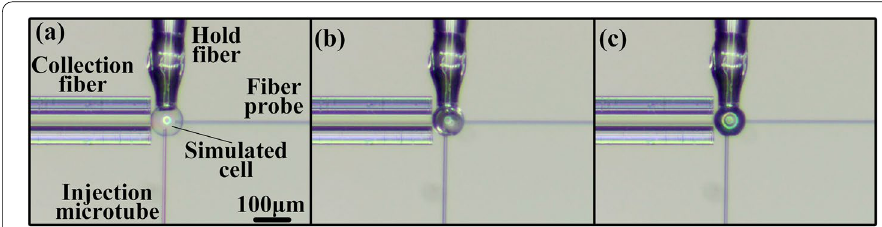
Fig.8 a Physical micrograph of tapered optical fiber probe probing a simulated cell. b The liquid was being injected into the simulated cell. c Liquid-filled simulated cell